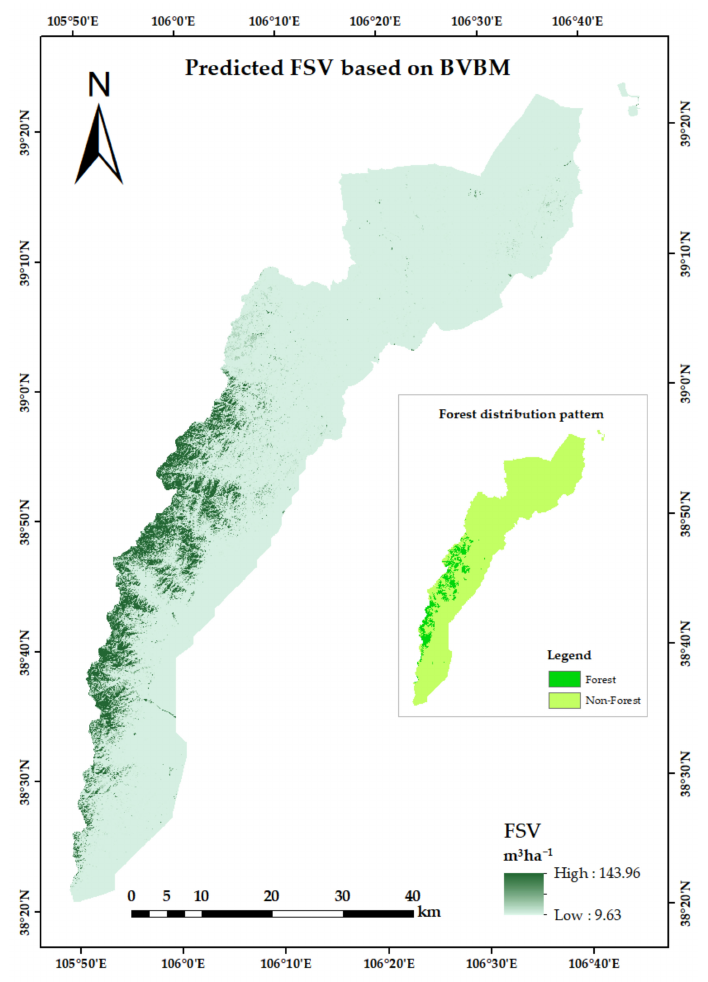
Figure 9. Spatial distribution of the predicted FSV, and forest distribution of the Helan